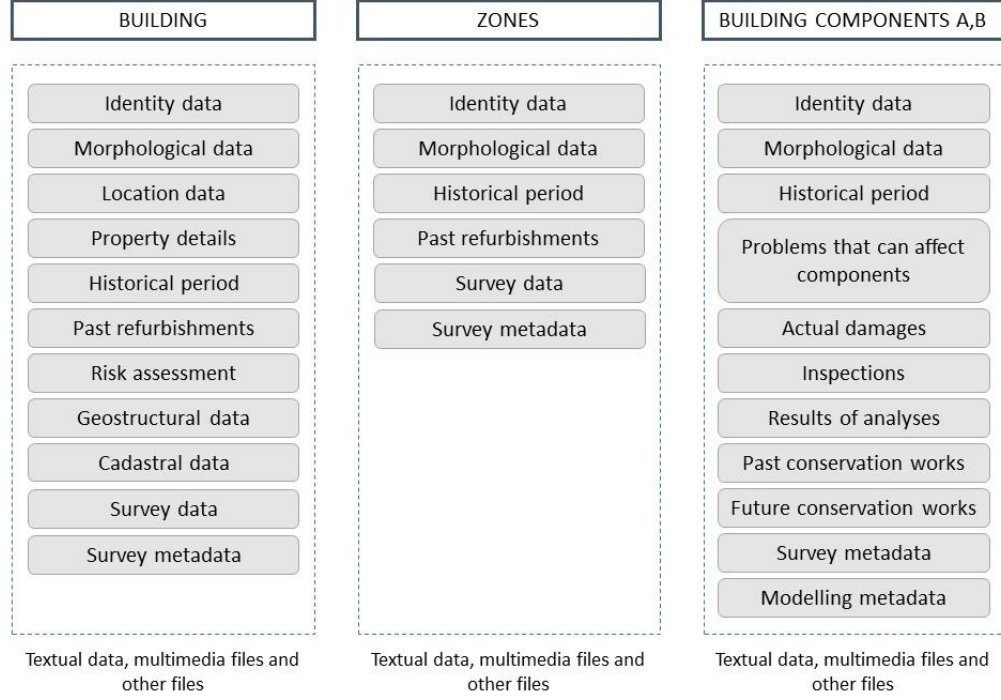
Figure 2. Summary of the data entered in the database, grouped by levels of detail.